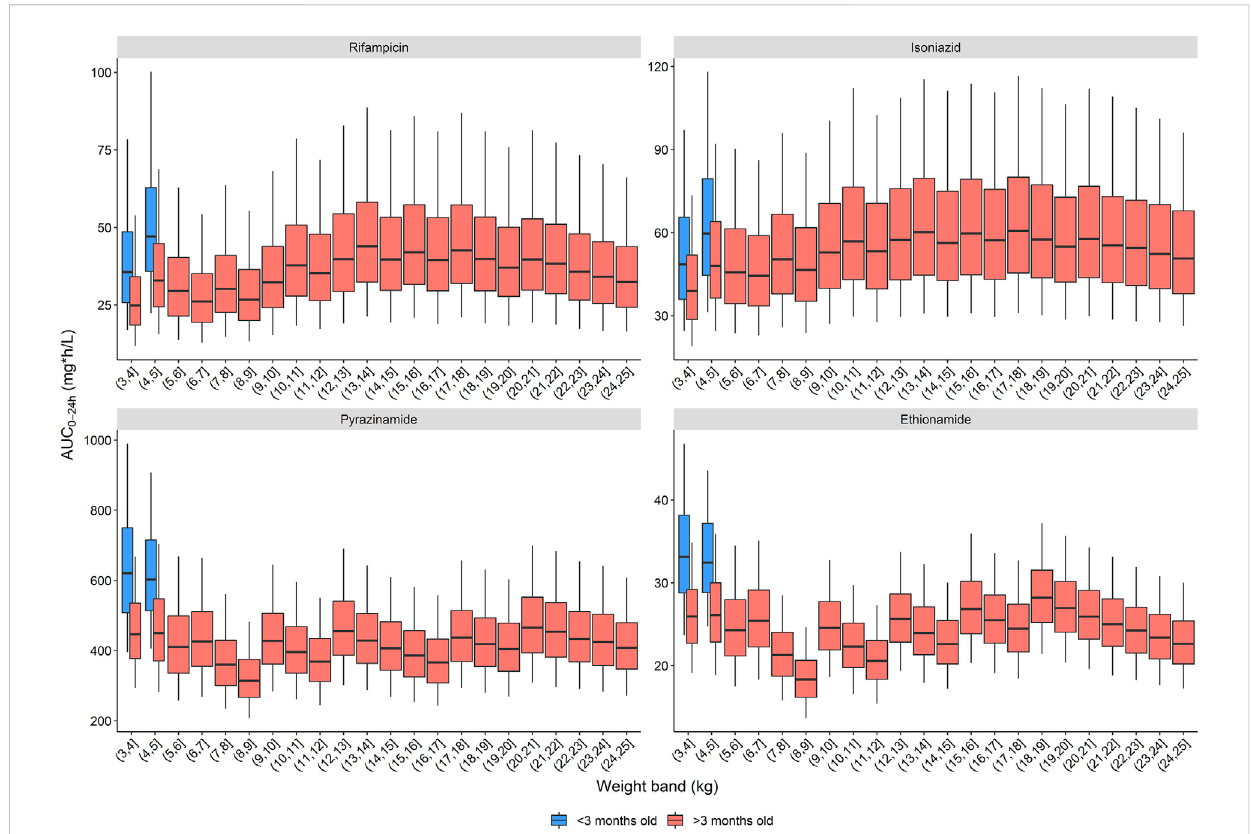
FIGURE 1 Areaundertheconcentration-timecurveovera24-hdoseinterval(AUC 0 – 24h )afterdosingchildrenaccordingtotheSouthAfricandosingtable.The box represents the median and 25 th and 75 th percentile. The whiskers represent the 5 th and 95 th